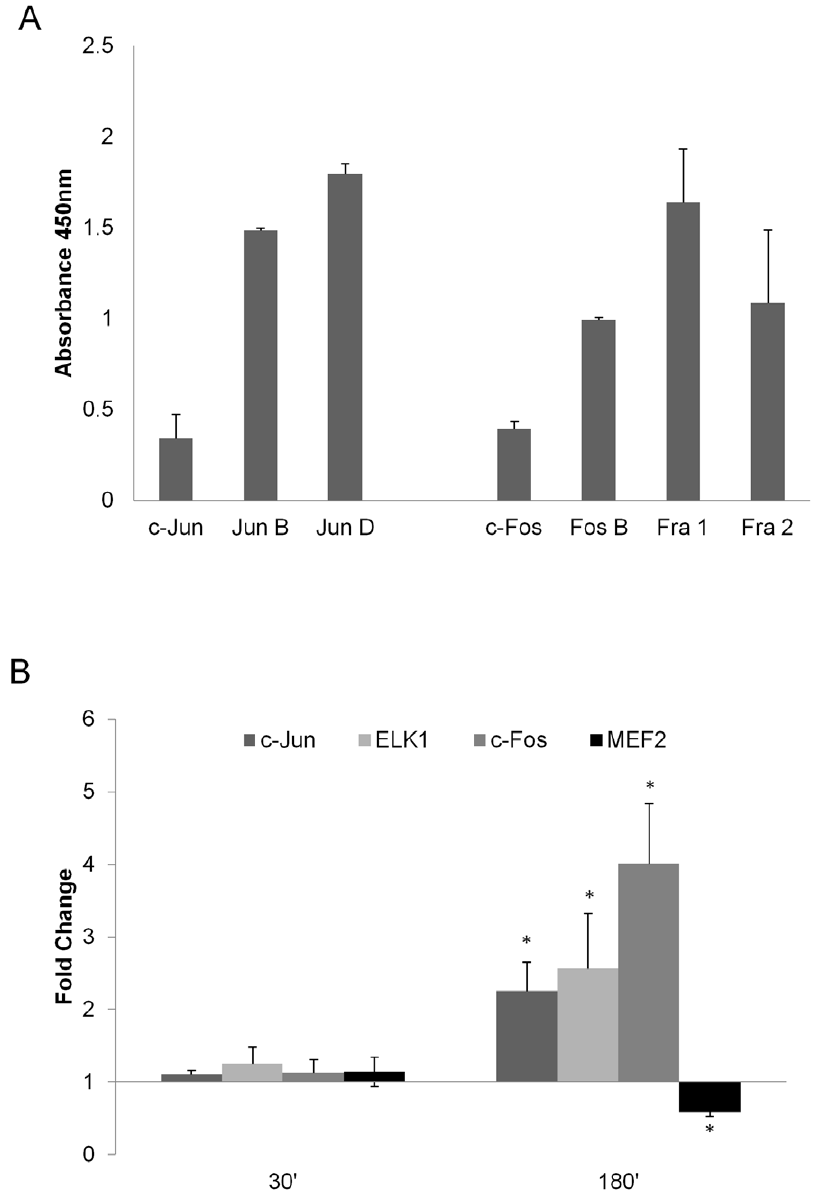
Figure 2. Activation of MAPK transcription factors by C.albicans in A431 vaginal epithelial cells. (A) Resting levels of DNA binding activity (absorbance values) of AP-1 transcription factor members in nuclear extracts from A431 ECs, measured by TransAm ELISA. (B) Changes in DNA binding activity of c-Jun, Elk1, c-Fos, and MEF2 in nuclear extracts of A431 ECs 30 and 180 min post-infection with C. albicans SC5314 by TransAm ELISA. These MAPK-activated transcription factors have previously been identified as showing altered DNA binding activity in oral ECs. Data are represented as fold change relative to resting levels at 0 h. A C. albicans :EC MOI of 10:1 was used. Data represent mean values 6 SEM and are representative of a minimum of three independent experiments. Statistical analysis (B) of raw data for infected versus uninfected cells was performed using the unpaired, two-tailed t-test * p , 0.05.